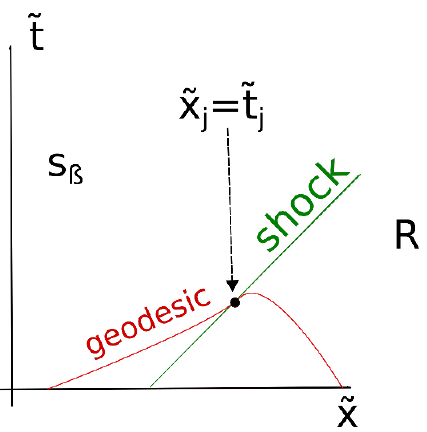
Figure 10 . A cartoon of a curve used in our procedure, projected onto a ~ t; x hypersurface. S (cid:25) and R denote regions of spacetime, the steady state and right thermal region, respectively. The red line is a piecewise geodesic (it is a geodesic in any of both regions) connecting boundary endpoints and a point on a shockwave (~ x = ~ t in our coordinates). Then the (renormalised) length of that geodesic is extremised with respect to the coordinates of the joining point, which yields the entanglement